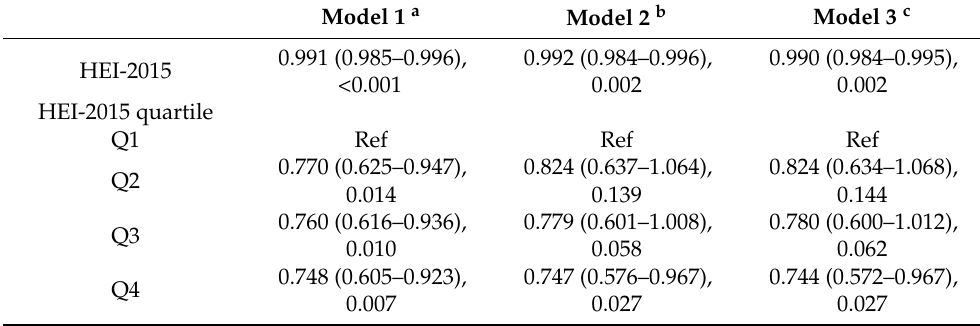
Table 3. Association of HEI-2015 and cataract using PSW-weighted